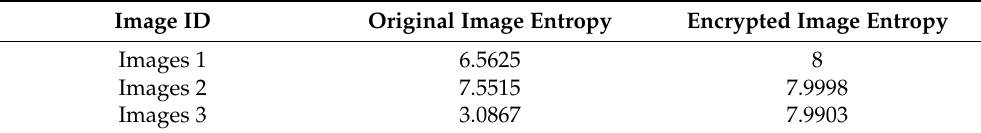
Table 4. Entropy Analysis.